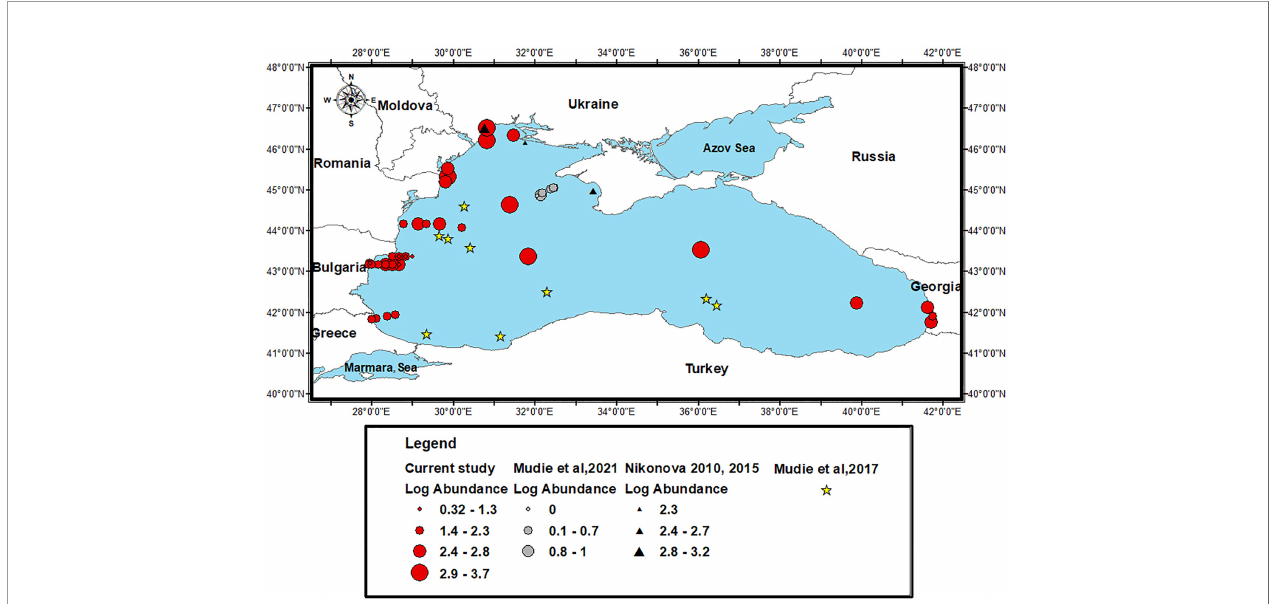
FIGURE 2 | Distribution of S. acuminata complex cysts in the Black Sea sediments (data according to Mudie et al., 2017 are not quantitative and are shown only as presence